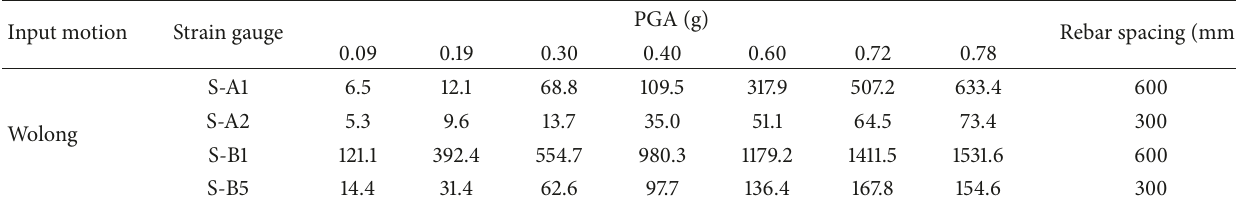
wall A and wall B. The experimental results show that the failure modes of latticed concrete infill walls with the height- width ratio of 2.57 and 1.57 were bending shear mode when subjected to earthquake excitation. From Figure 19(b), the maximum concrete tensile strain was 120.0 𝜇𝜀 (measuring point S-B16) under Wolong record input with PGA = 0.78 g. Because the input motions was only applied in the 𝑦 -direction, the maximum measuring points S-C8 and S-C9 (out-of-plane) were just 28.4 𝜇𝜀 and 28.9 𝜇𝜀 , respectively, which were smaller than that of the measuring points S-A11 and S-B16 (in-plane). According to the code